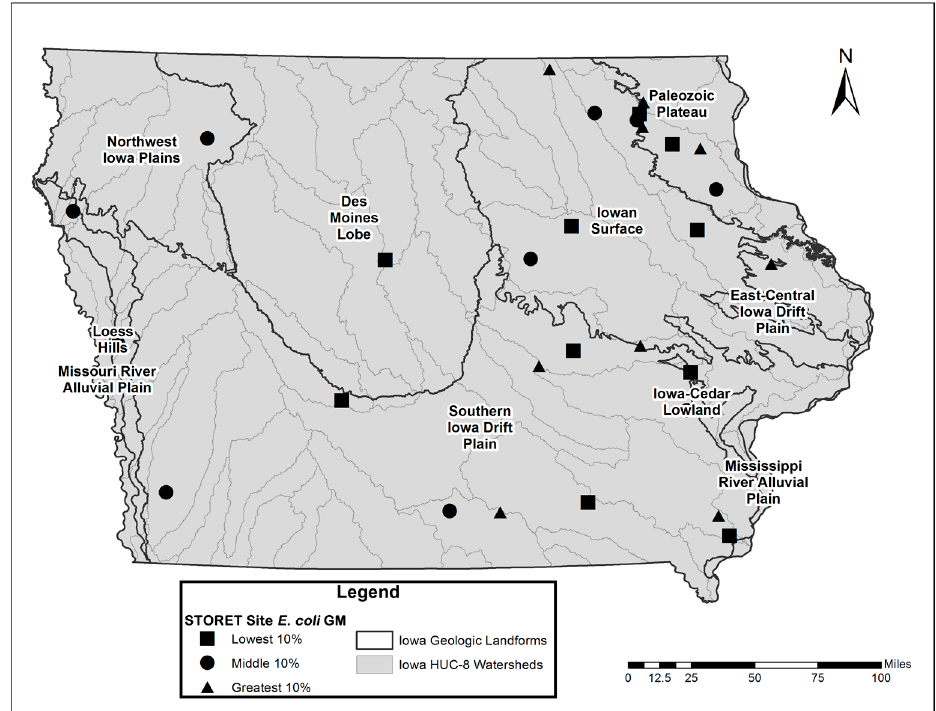
Figure 2. Spatial distribution of Iowa Storage and Retrieval (STORET) sites analyzed in this study.